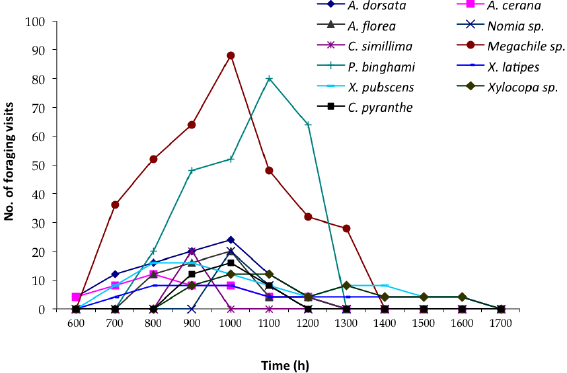
Figure 2. Hourly foraging activity of insects on Derris trifoliata